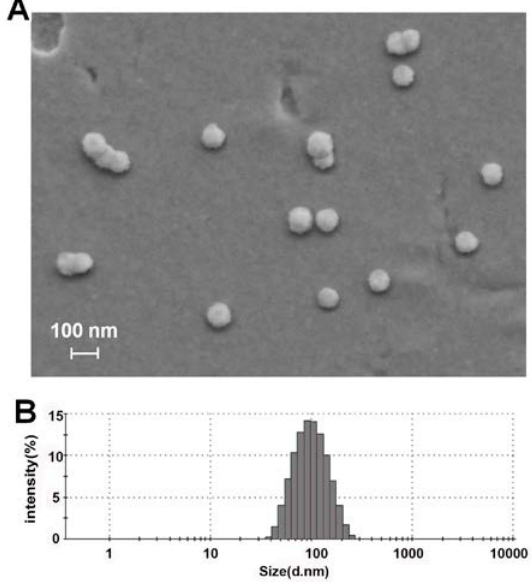
Figure 1. Morphology ( A ) and particle sizing distribution ( B ) of PFMA nanoparticles in the dialyzed emulsion.